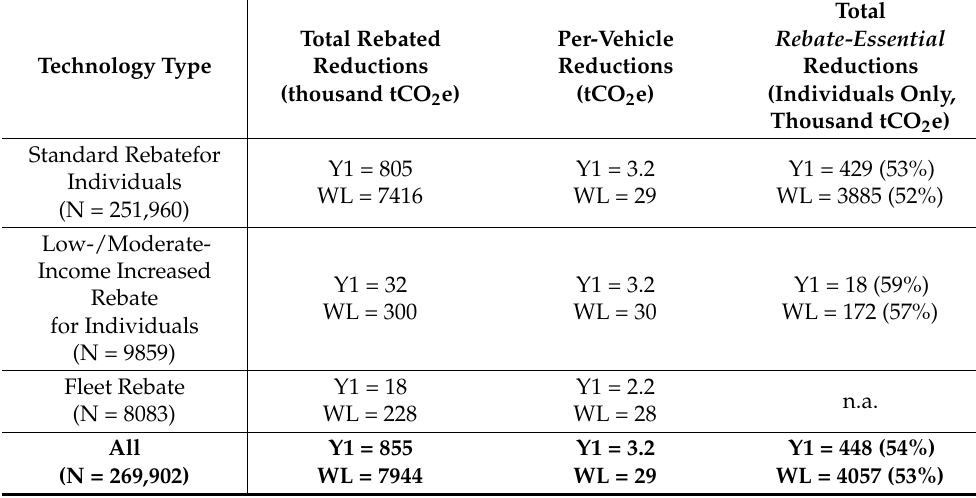
Table A5. GHG Reduction Estimates by Technology Type and Quantification